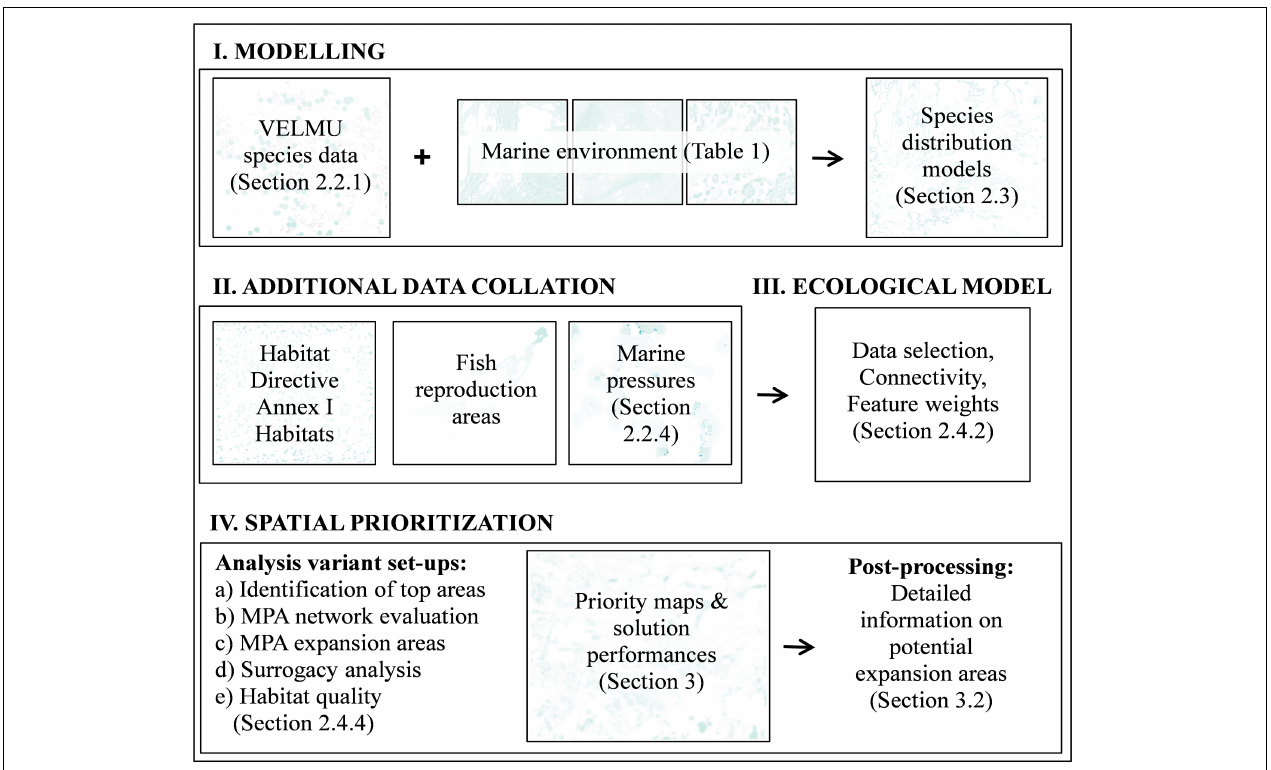
FIGURE 2 | Schematic of work flow for spatial prioritization. Spatial prioritization starts with the data acquisition process. In this case data on species, environments, habitats, and human activities was collated, and pre-processed, for spatial prioritization by statistical modeling and extrapolation over the seascape at a high resolution of 20